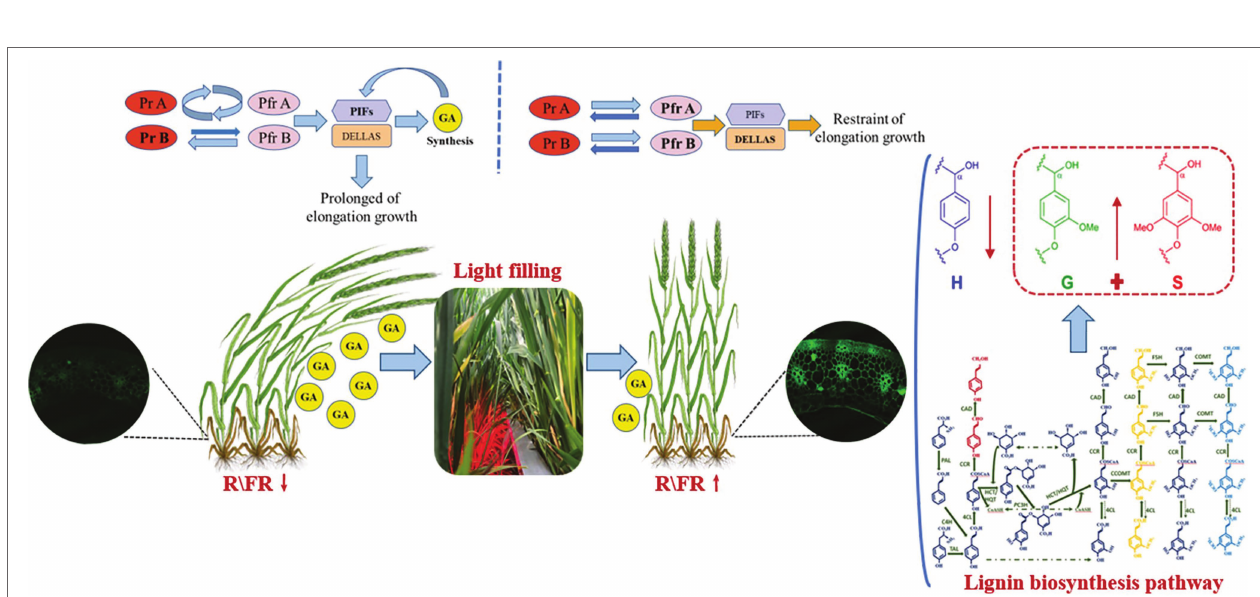
FIGURE 9 | Red: far-red ratio (R/FR) at the base of canopy under different treatments. SN16 and SN23 represent the lodging-sensitive cultivar Shangnong16 and the lodging-resistant cultivar Shangnong23. CK represents the normal light, RL represents the red light, and FRL represents far-red light. Vertical bars above mean values indicate SDs ( n = 5). Means show significant differences between treatments according to the LSD ( p < 0.05).